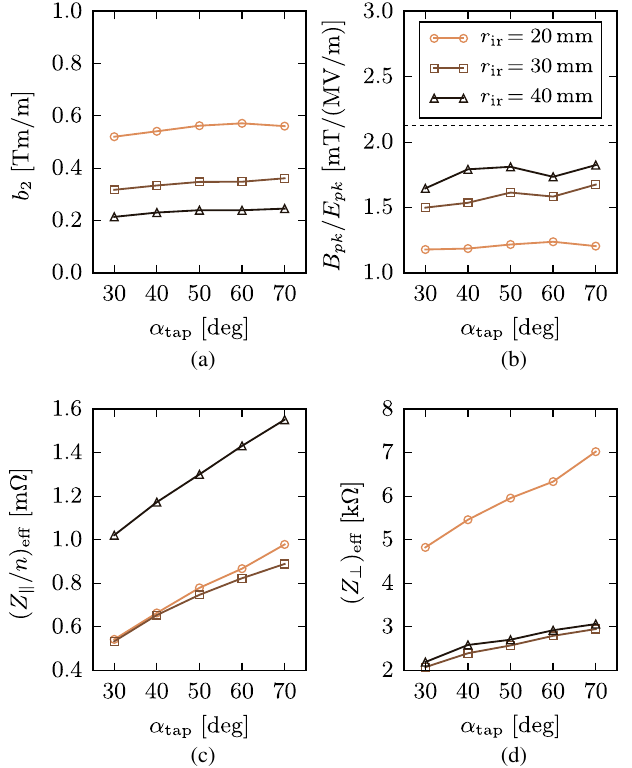
FIG. 14. Properties of the optimized 800 MHz four-vane cavities with different iris radius r and tapering angle α . ir tap (a) Maximum achievable quadrupolar strength per cavity. (b) Ratio of surface peak fields. The effective longitudinal (c) and transverse (d) impedance are related to a whole system of cavities to provide the quadrupolar strength in Table